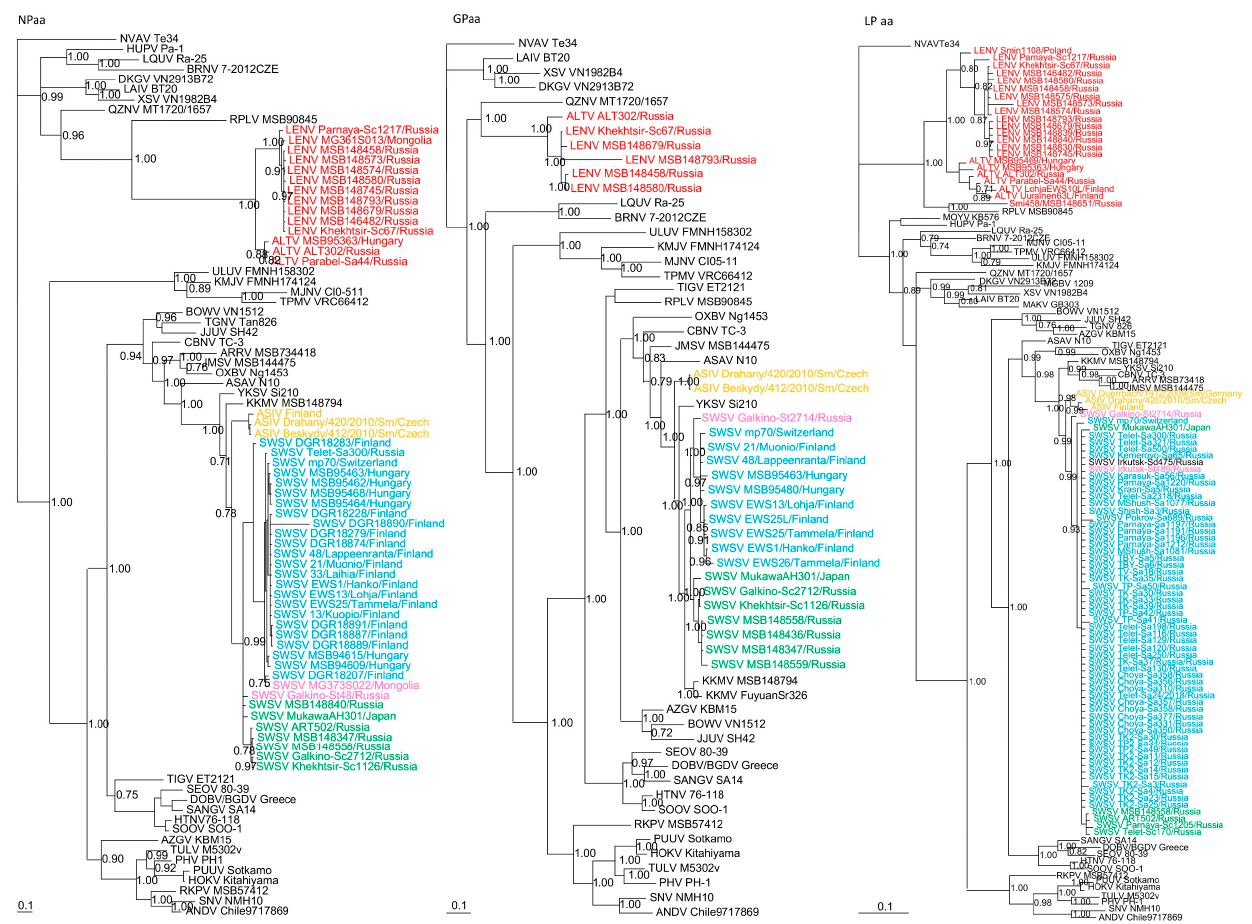
Figure 3. Phylogenetic trees generated by the Bayesian method, based on the nucleocapsid protein (NPaa), glycoprotein (GPaa) and RNA-dependent RNA polymerase (LPaa) of ALTV (red), SWSV strains from Sorex araneus (light blue), SWSV strains from Sorex caecutiens (green), SWSV strains from Sorex tundrensis (light pink) and Asikkala virus (ASIV) from Sorex minutus (yellow). The phylogenetic positions of other representative hantaviruses hosted by rodents, shrews, moles and bats are also shown. GenBank accession numbers are as shown in Figure 2 and in Supplementary Table S2.